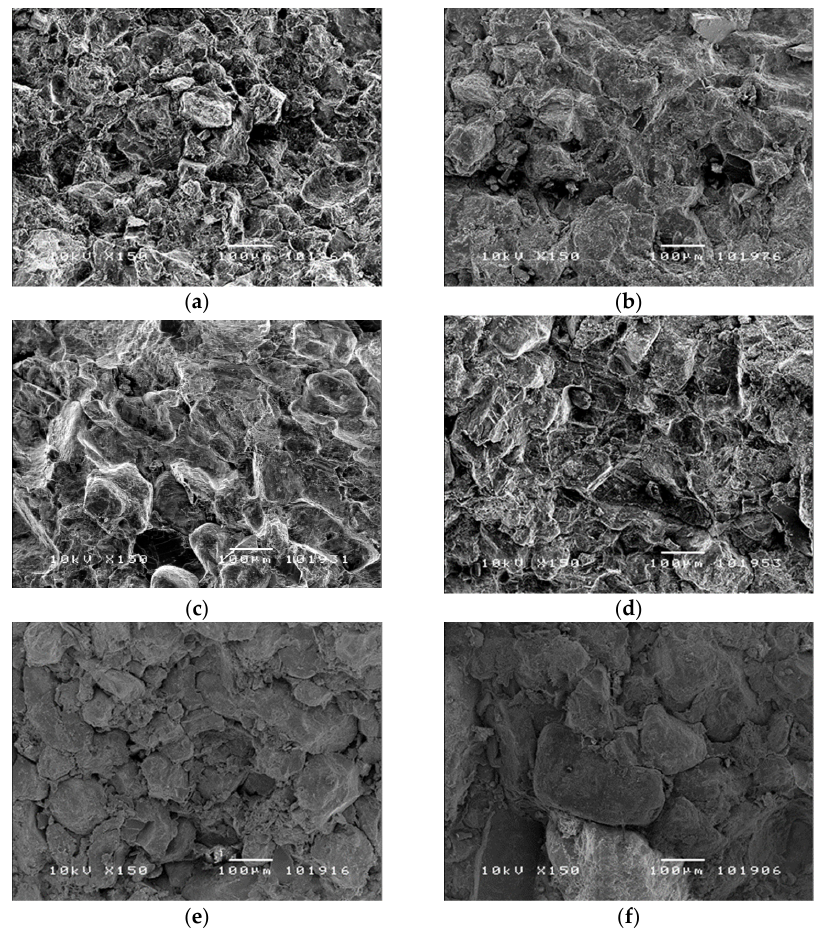
Figure 7. Fracture morphology of red sandstone at different temperatures. ( a ) 25 °C red sandstone, ×150, ( b ) − 5 °C red sandstone, ×150, ( c ) − 10 °C red sandstone, ×150, ( d ) − 20 °C red sandstone, ×150, ( e ) − 30 °C red sandstone, ×150, ( f ) − 40 °C red sandstone, ×150.